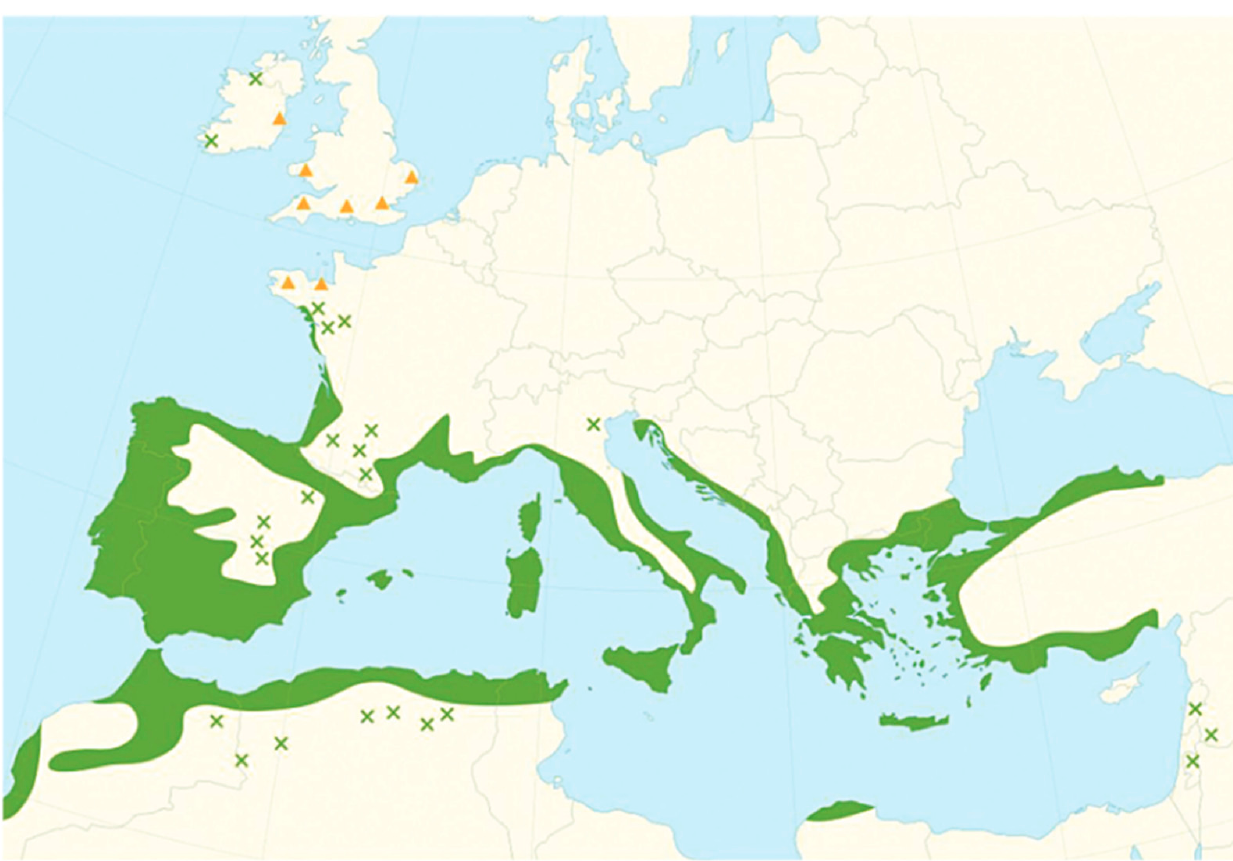
Figure 2. Geographic distribution of Arbutus unedo L. (source: Caudullo et al. [16] , according to Skendrovi ć Babojeli ć et al. [17] ). Legend: natural habitat; ✖ isolated populations; ▲ introduced and naturalized populations.